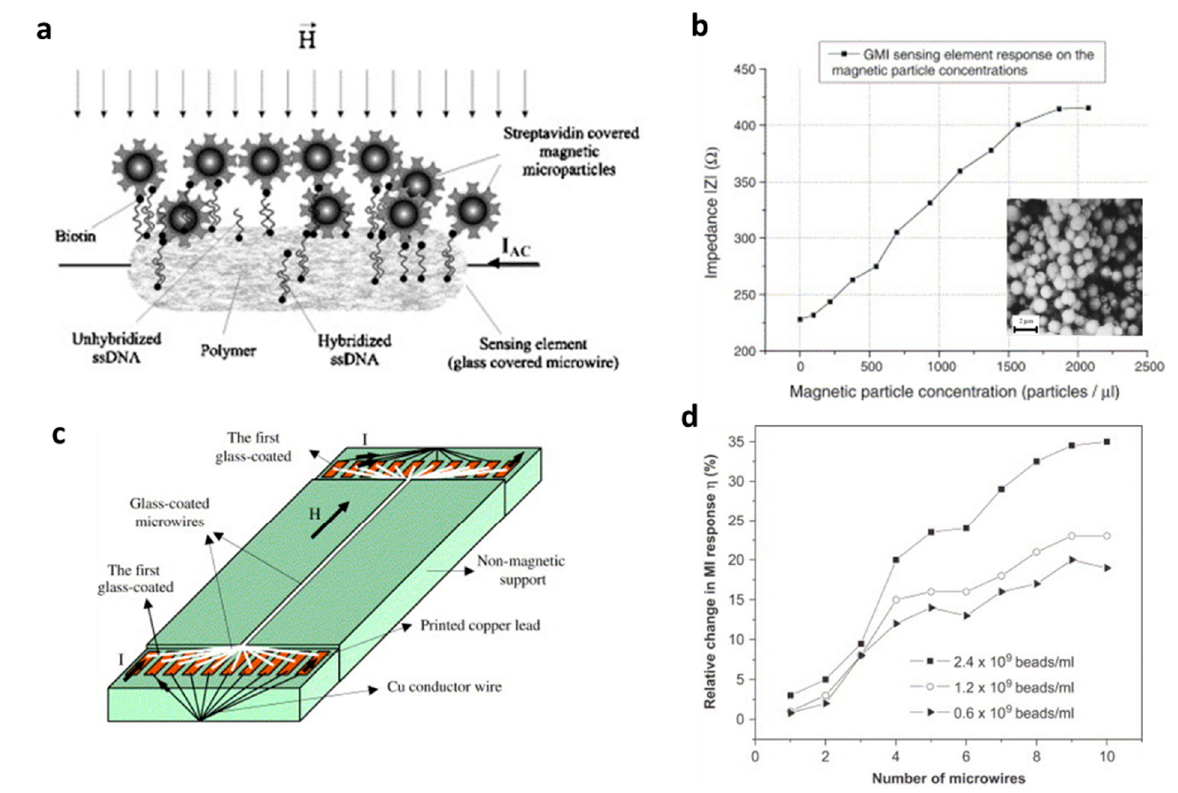
Figure 6. ( a ) The principle of a GMI-based magnetic biosensor using the ssDNA hybridization phenomenon as an example; ( b ) impedance response of the sensing element on the magnetic particles concentration. Reprinted with permission from Ref. [24]. Copyright 2022 Elsevier; ( c ) schematic design of the multiwire-based MI device; and ( d ) relative change in MI response as a function of the number of active glass-coated microwires for different bead concentrations. Reprinted with permission from Ref. [25]. Copyright 2022 Elsevier.